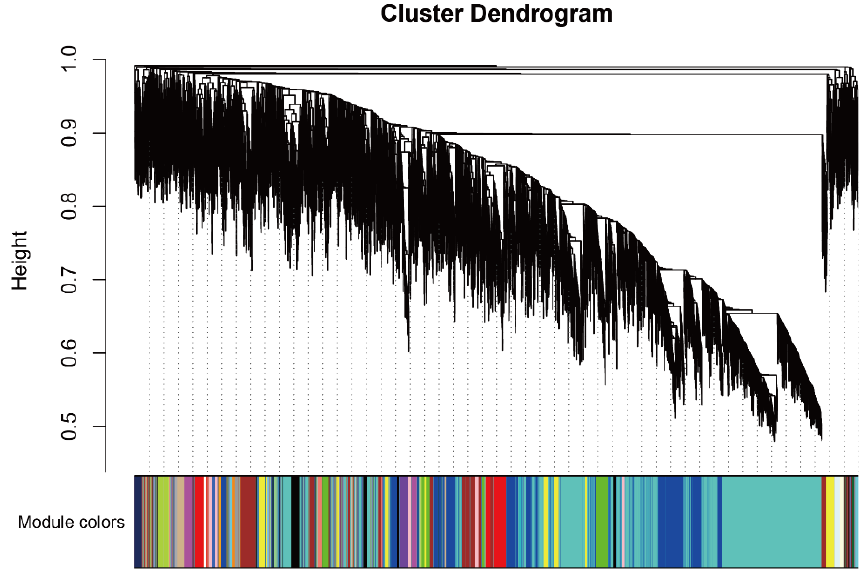
Figure A7. Co-expression modules cluster dendrogram.